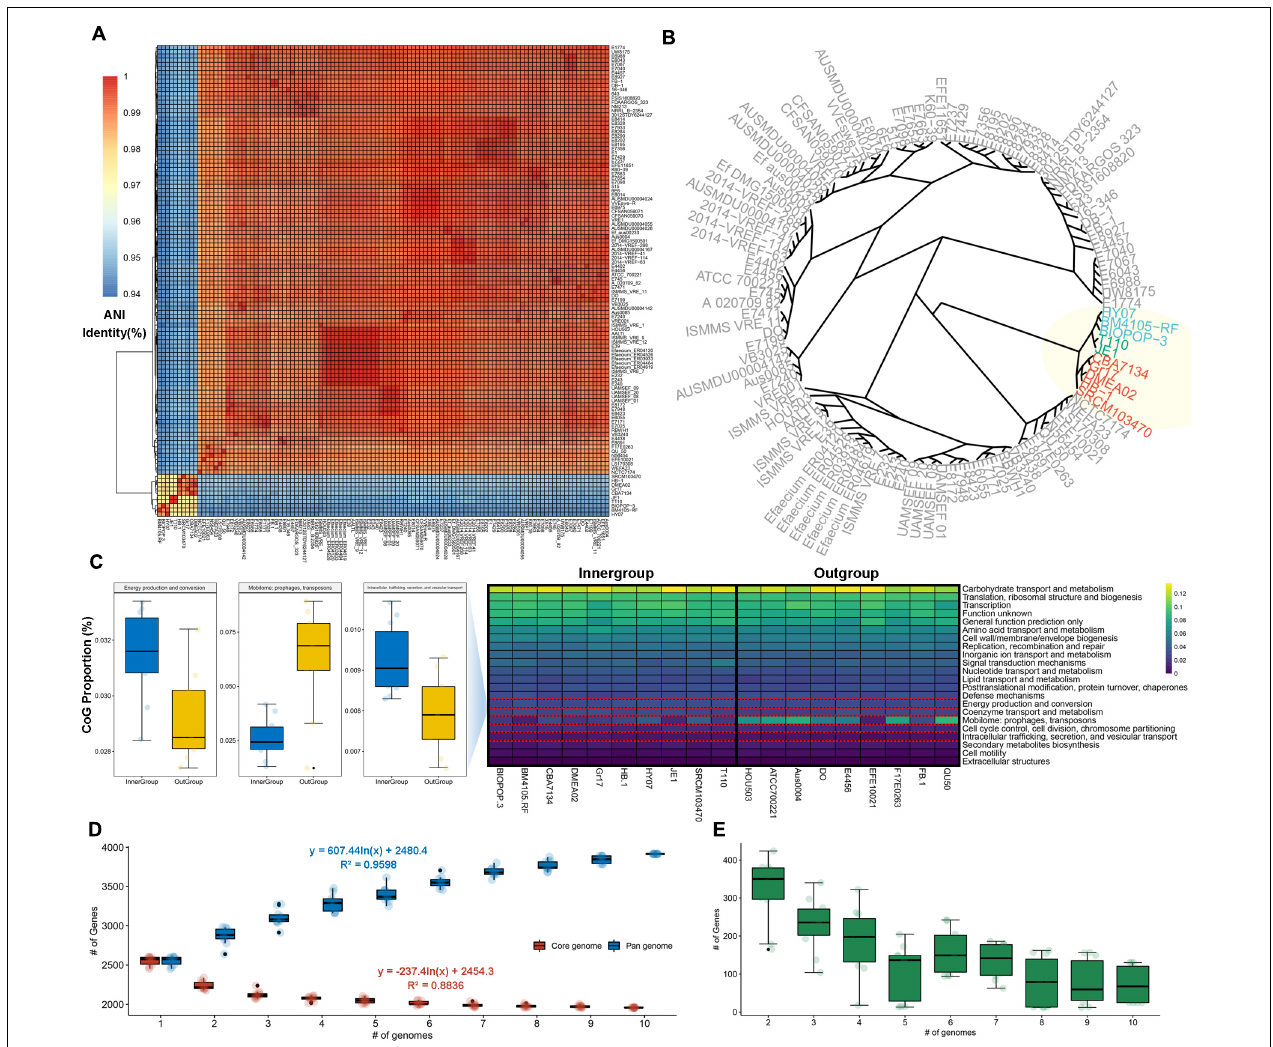
FIGURE 2 | Comparative genomics with 112 E. faecium strains. (A) Hierarchical clustering based on ANI values of 112 E. faecium strains. (B) BIOPOP-3 WT strain was clustered with nine other E. faecium strains. (C) The three COG functional terms significantly differed between the inner-group containing BIOPOP-3 and the rest of E. faecium strains. (D) Pan and core genome estimates of 10 E. faecium strains in the inner-group containing BIOPOP-3. (E) The number of newly identified genes observed when new genomes are added